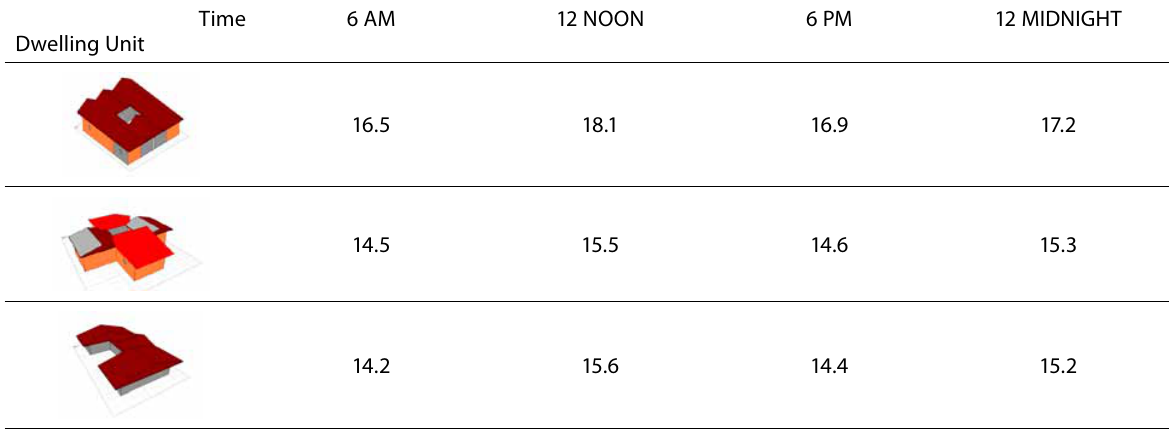
Table 6. Temperature measurements inside different types of courtyard dwelling units selected for detailed study at different times of the day and night on 4 th january in the coldest week of the year Time Dwelling